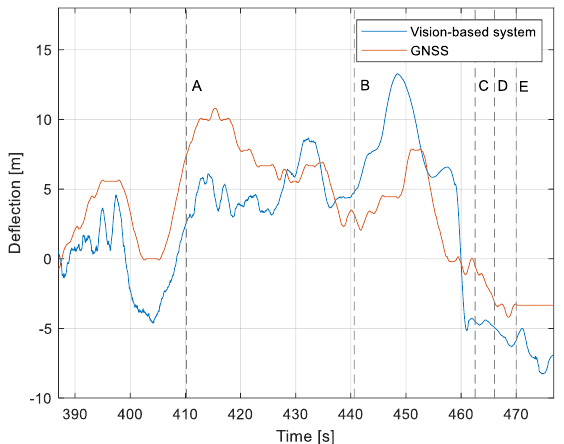
Figure 19. Linear lateral deflection from the center line: Flight no. 2 (markers A – E correspond to the moment of recording the images in Figure 11.